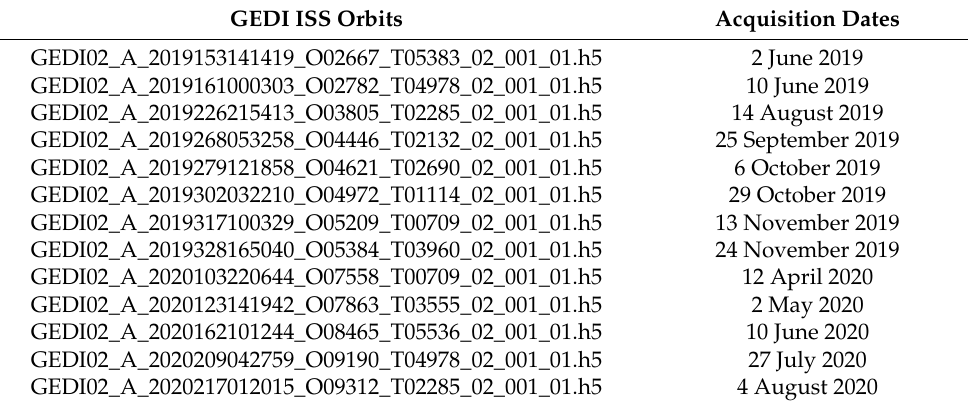
Table 2. GEDI L2A products downloaded and acquisition